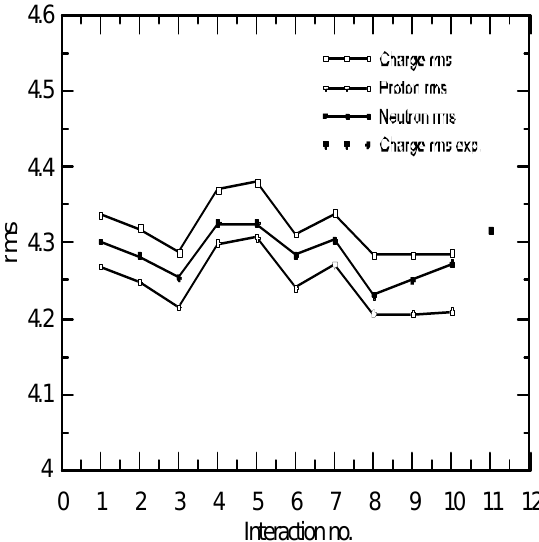
Fig.6: The calculated proton and neutron rms radii for 92 Mo nucleus using different Skyrme